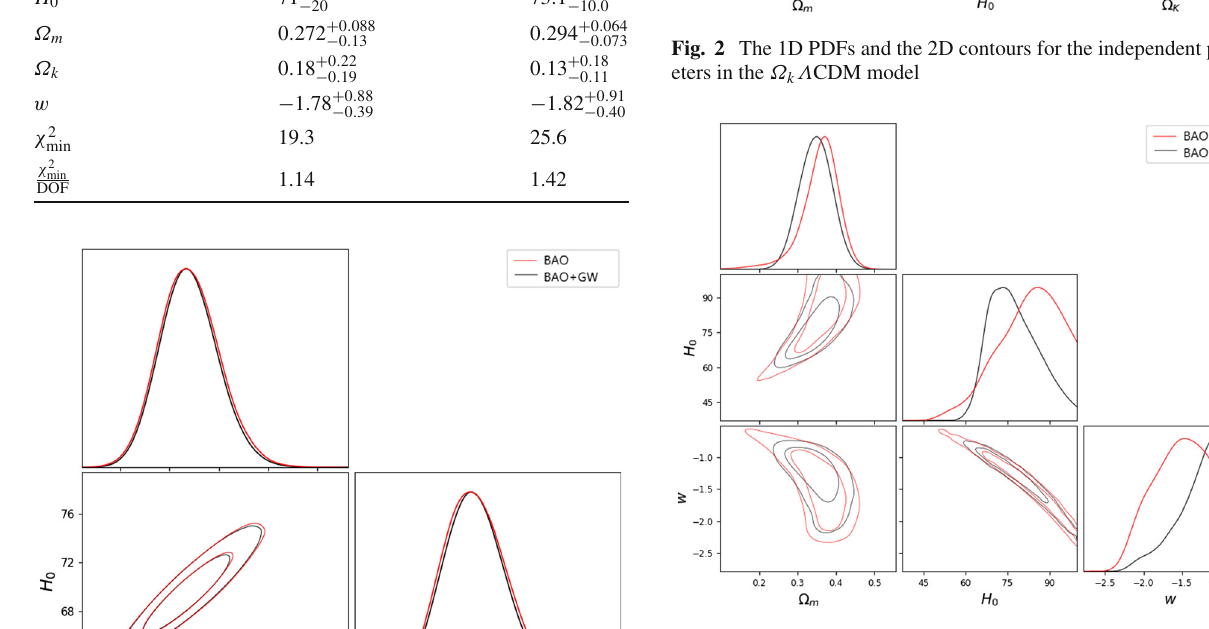
Fig. 3 The 1D PDFs and the 2D contours for the independent param- eters in the w CDM